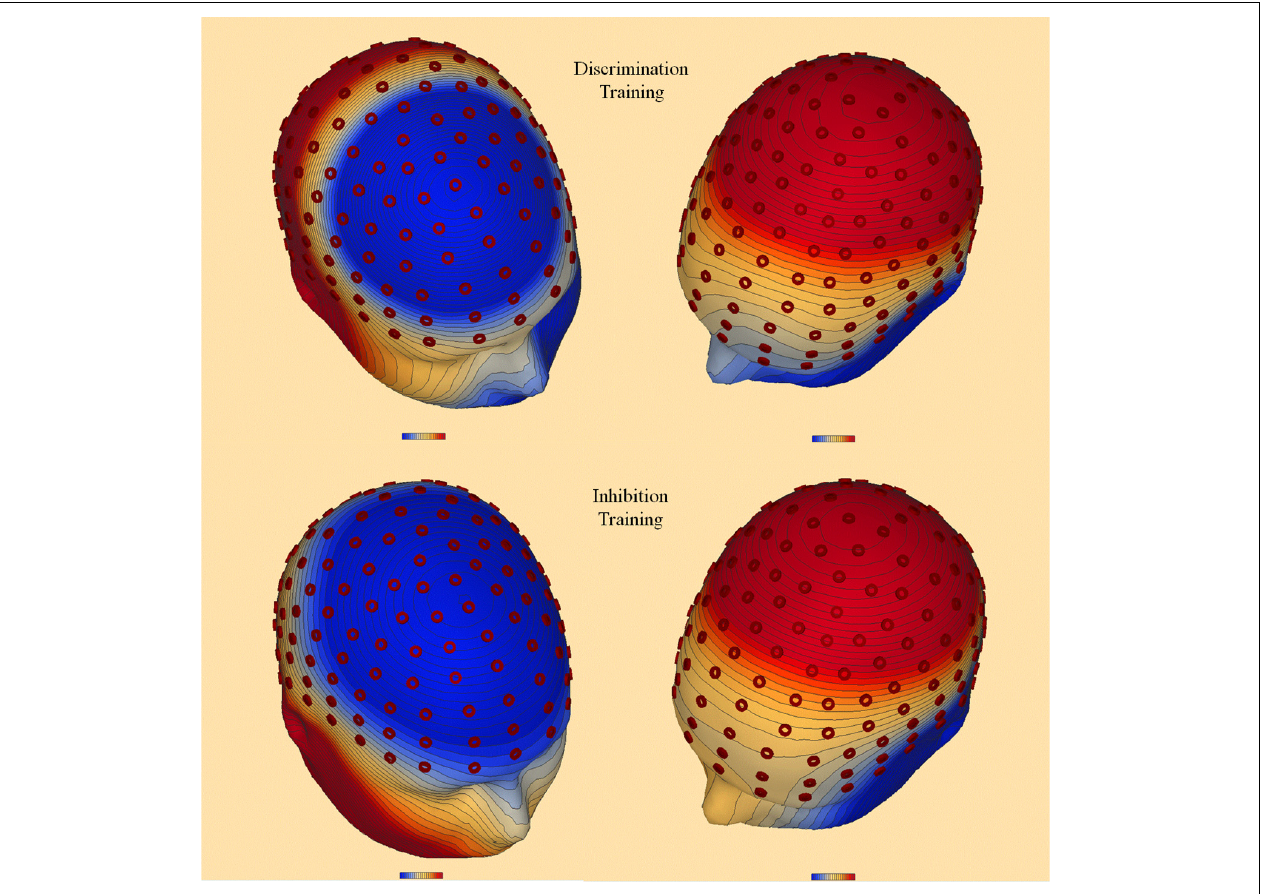
FIGURE 2 | Topographic voltage maps to targets at pretest during N2 (200–400 ms after stimulus onset; Left) and P3 (400–900 ms after stimulus onset; Right) time epochs, separately for the discrimination group (Top) and the inhibition group (Bottom). Center-of-mass for N2 was localized over central electrode sites and for P3 over parietal electrode